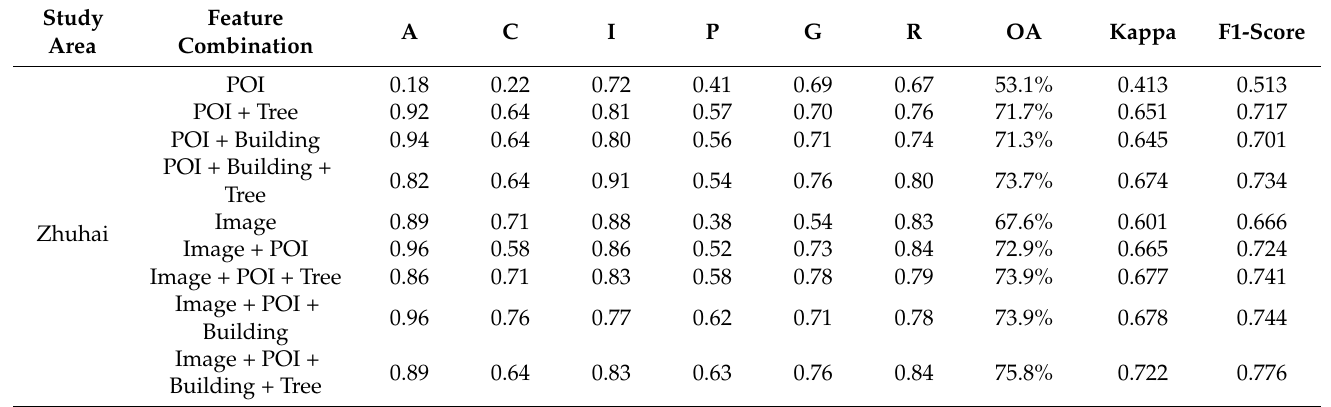
Table 8. UFZ classification results in Zhuhai based on different feature combinations.